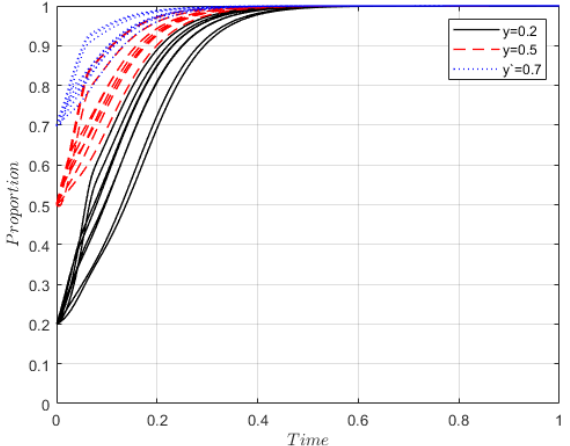
Figure 10. Evolutionary diagram when y differs.